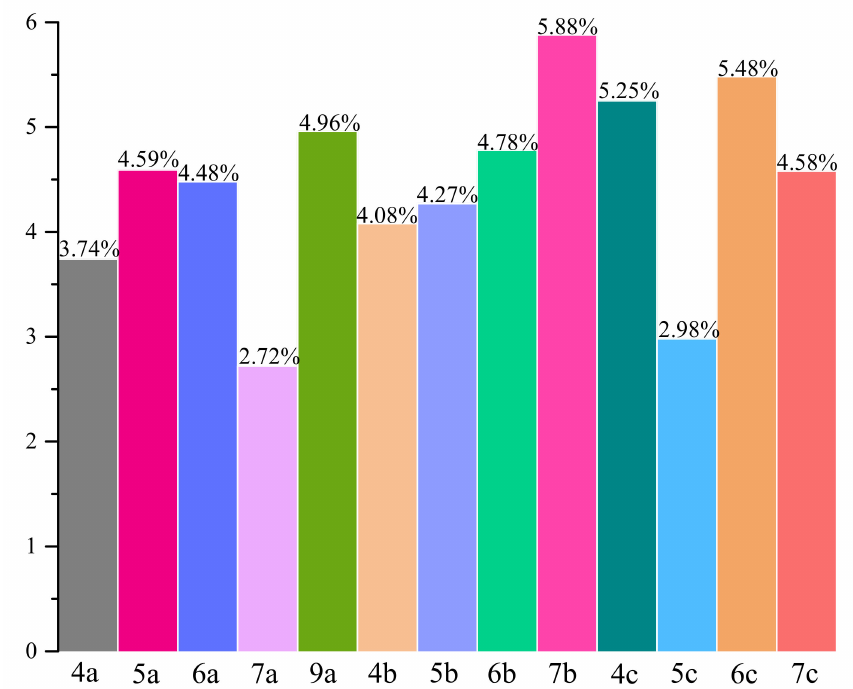
Figure 11. The comparison of changes in the α -helix(%) of BSA after adding 10 portions of each analyzed